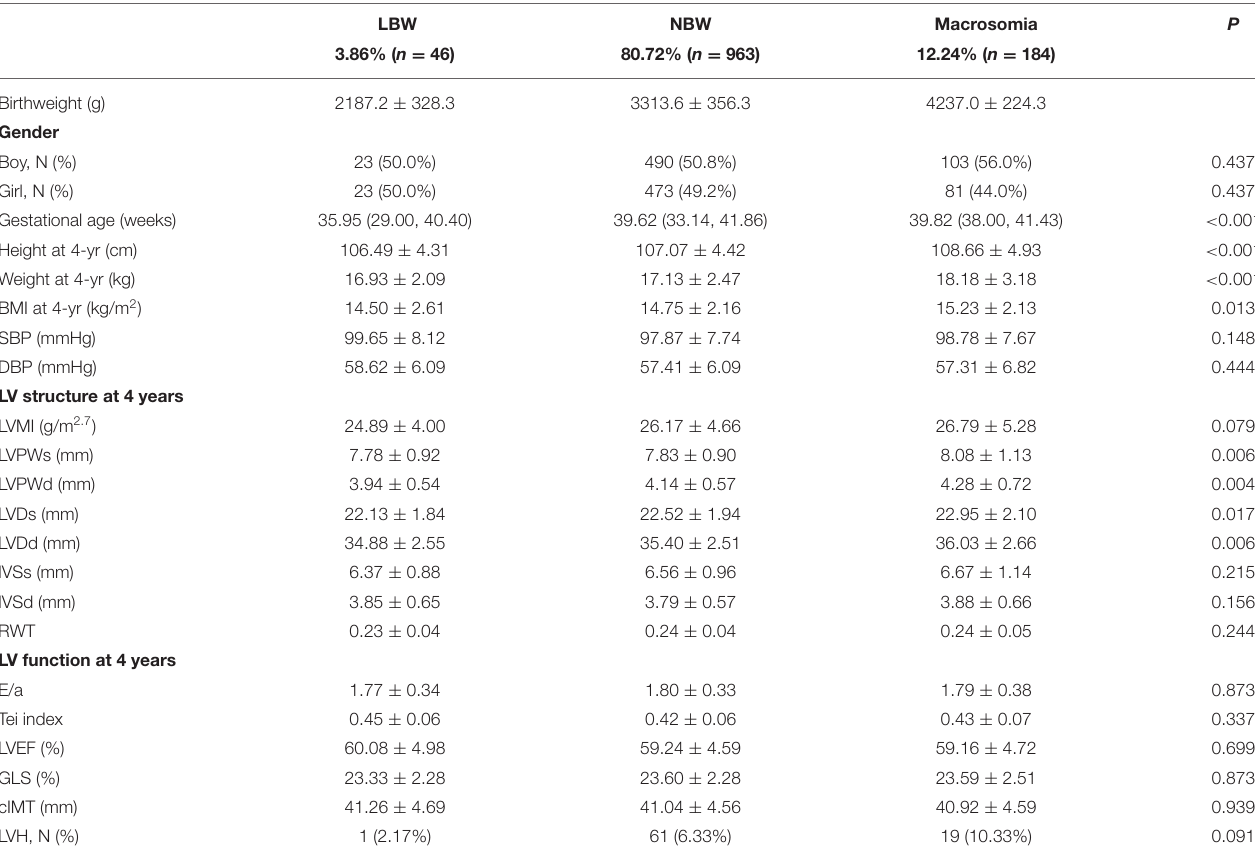
TABLE 1 | Basic and cardiovascular characteristics of different birthweight